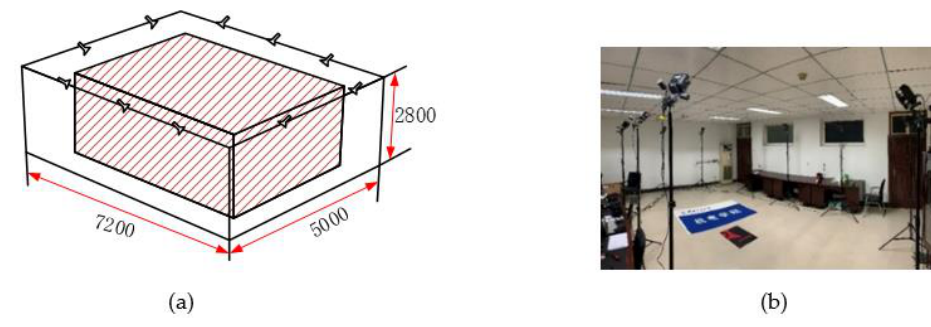
Figure 2. Configuration scheme. ( a ) Layout space ( b ) Experimental setup.